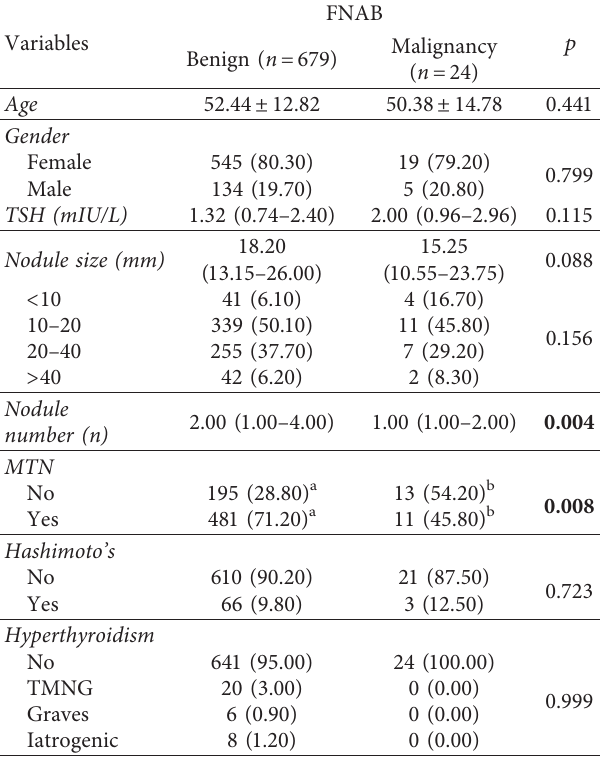
Table 2: Demographic and clinical features of benign and ma- lignancy in fine-needle aspiration biopsy (FNAB) result. Variables